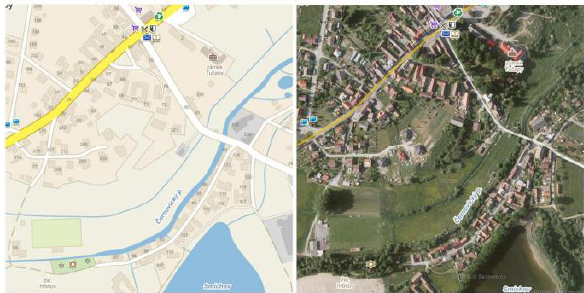
Figure 5. The example of experimental stimuli – conventional map (left) and image map (right).